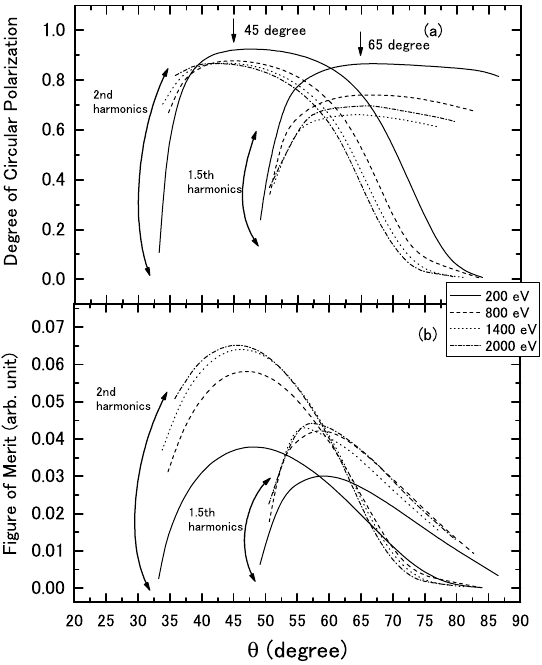
FIG. 3. The geometrical definition of and (cid:31) . The length j OA j presents K . The angles and (cid:31) are determined by K K , and K y 2 x